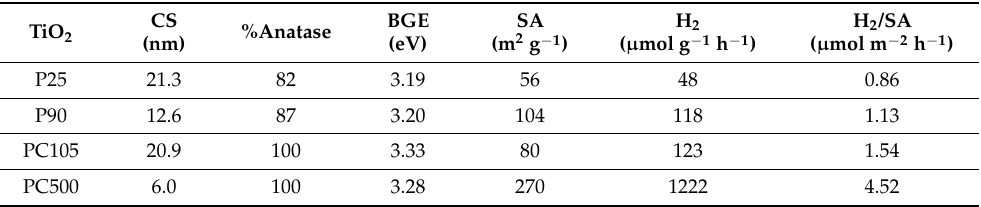
Table 1. Characteristic values of commercial TiO 2 catalysts (CS: crystallite size, SA: surface area, BGE: indirect bandgap energy), and H 2 productivity (c TiO 10 vol% ethanol).